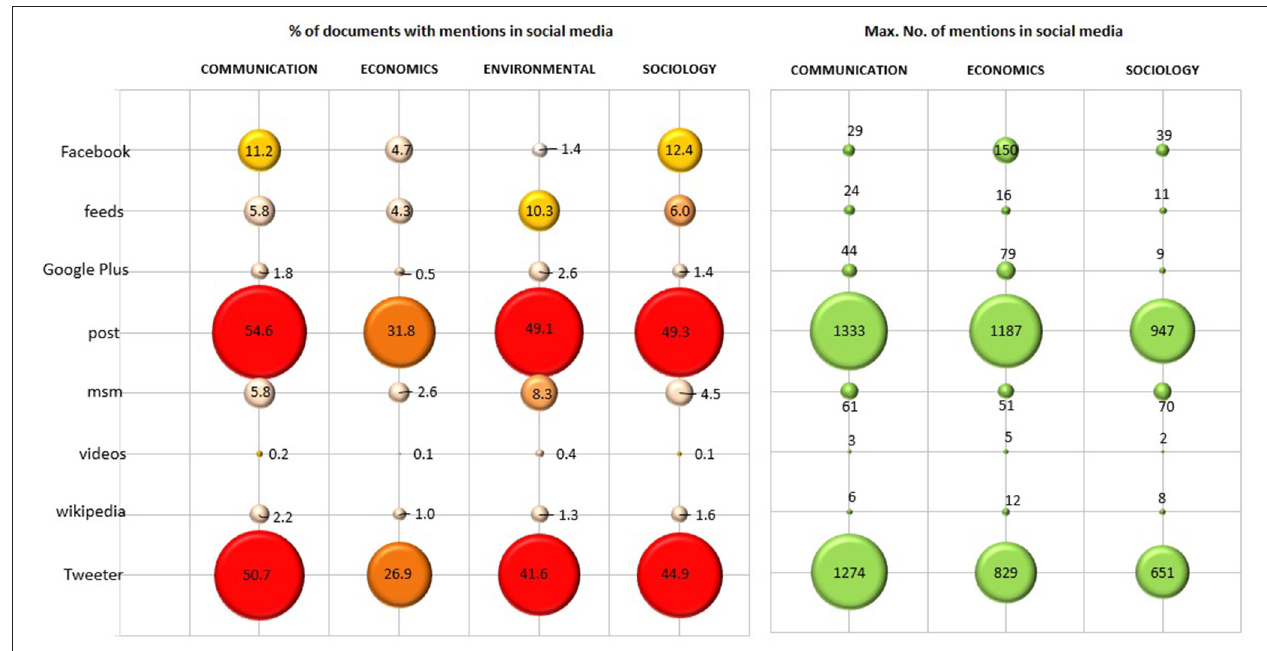
FIGURE 6 | Social media mentions by type of source and